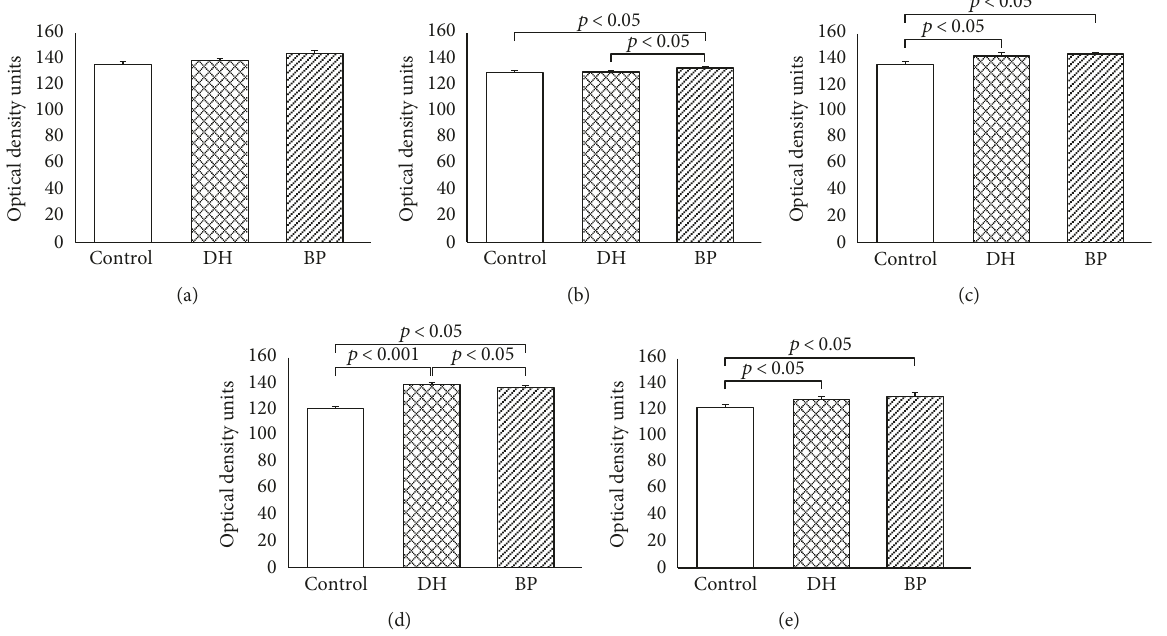
Figure 2: Morphometric analysis of JAK1 (a), JAK2 (b), STAT1 (c), STAT3 (d), and STAT5 (e) immunoexpression in keratinocytes, evaluated with Western blot. The results are presented as % optical density over the background (the mean ± SD). Control — normal skin. DH — dermatitis herpetiformis, skin lesions. BP — bullous pemhigoid, skin lesions. The level of signi fi cance is de fi ned where p < 0 05 . JAK1: C versus DH (NS), C versus BP (NS), and DH versus BP (NS). JAK2: C versus DH (NS), C versus BP ( p < 0 05 ), and BP versus DH ( p < 0 05 ). STAT1: C versus DH ( p < 0 05 ), C versus BP ( p < 0 05 ), and DH versus BP (NS). STAT3: C versus DH ( p < 0 05 ), C versus BP ( p < 0 05 ), and DH versus BP ( p < 0 05 ). STAT5: C versus DH ( p < 0 05 ), C versus BP ( p < 0 05 ), and DH versus BP